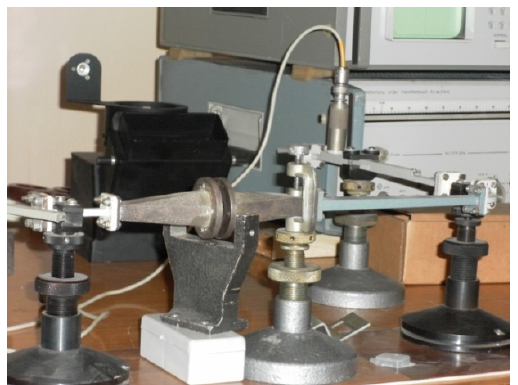
Figure 28. The scheme of the setup for measuring attenuation. (1) attenuator, (2) adapter, (3) incident wave DC, (4) measured object, (5) transmitted wave DC, and (6) matched load.